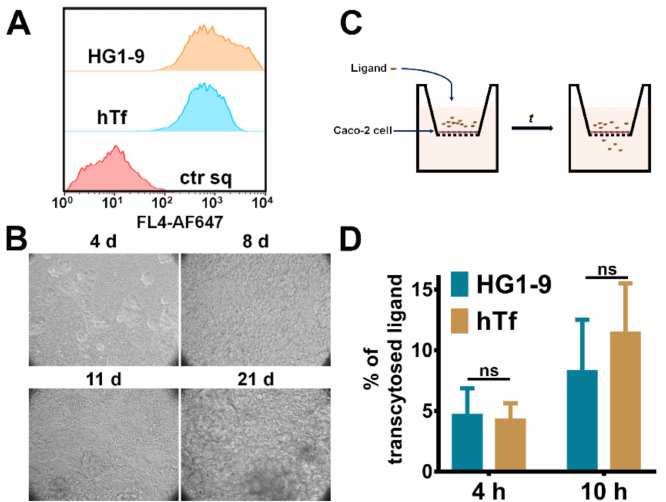
Figure 6. The transcytosis of aptamer HG1-9 across epithelium barrier. ( A ) Flow cytometry analysis of aptamer HG1-9 and hTf binding to Caco-2 cells at 4 ◦ C. ctr sq was the negative control. All of the DNA sequences and proteins were labeled by AF647. ( B ) The monolayer of Caco-2 cells on Transwell plate at different cultured days. ( C ) The schematic diagram of transcytosis of HG1-9 and hTf in Caco-2 cells. ( D ) Histogram of transcytosis efficiencies of HG1-9 and hTf in Caco-2 cells after incubation for 4 and 10 h. All data were presented as mean ± SE, n = 4, t -test, ns, not